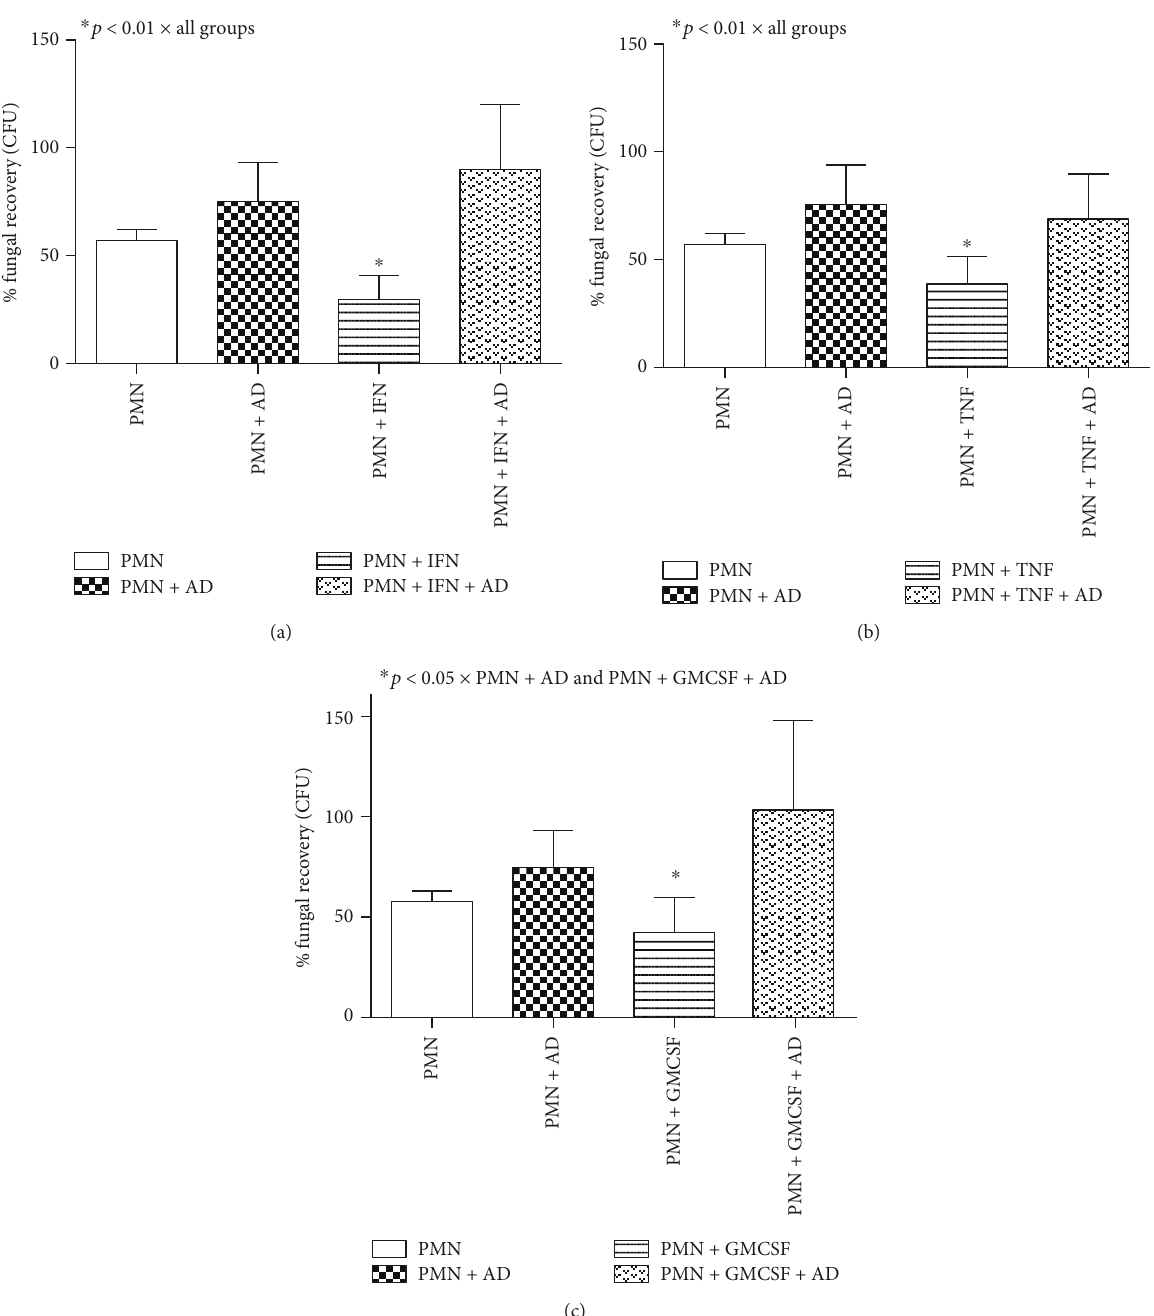
Figure 4: Percentage of fungal recovery by colony-forming unit (CFU) analysis of neutrophil (PMN) cultures treated or not with IFN- γ (a), TNF- α (b), and GM-CSF (c) for 18 hours in the presence or absence of the anti-Dectin-1 monoclonal antibody (AD) and challenged with Pb265 for 4 hours. Data are expressed as the mean of 8 healthy volunteer donors tested. Statistical signi fi cance between groups is